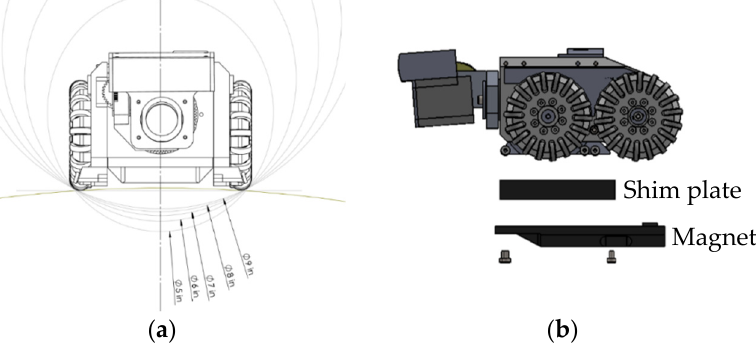
Figure 4. ( a ) The size of the robot relative to the pipes of different sizes. ( b ) The shim plate installation.